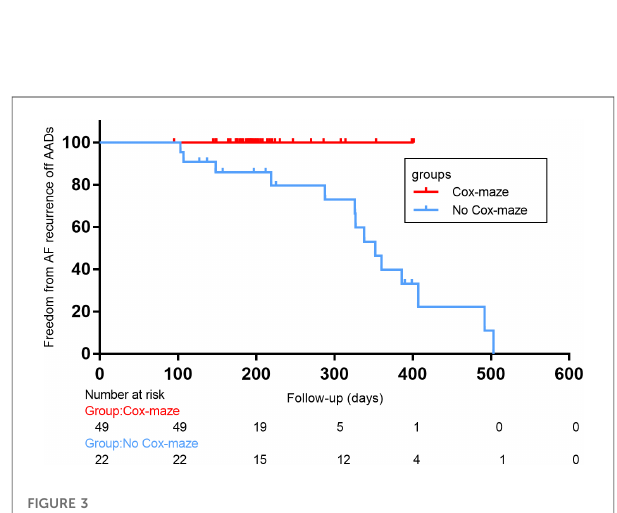
FIGURE 3 Freedom from atrial fi brillation (AF) recurrence off antiarrhythmic drugs (AADs) after concomitant Cox-maze IV procedure with surgical aortic valve replacement in patients with CAVD and AF. Log-rank statistic 8.422, p